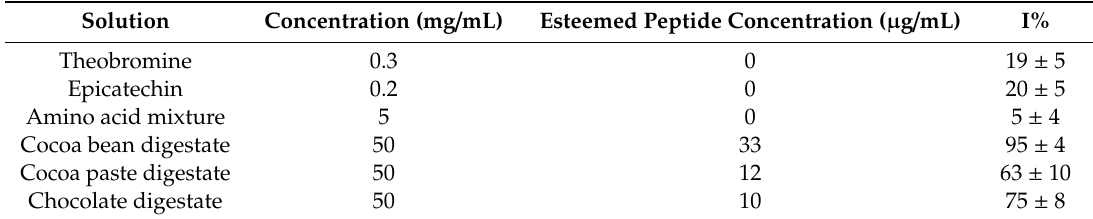
Table 2. ACE inhibitory activity of cocoa samples digestates, reported as percentage of inhibition respect to ACE maximum activity (relative to digestion